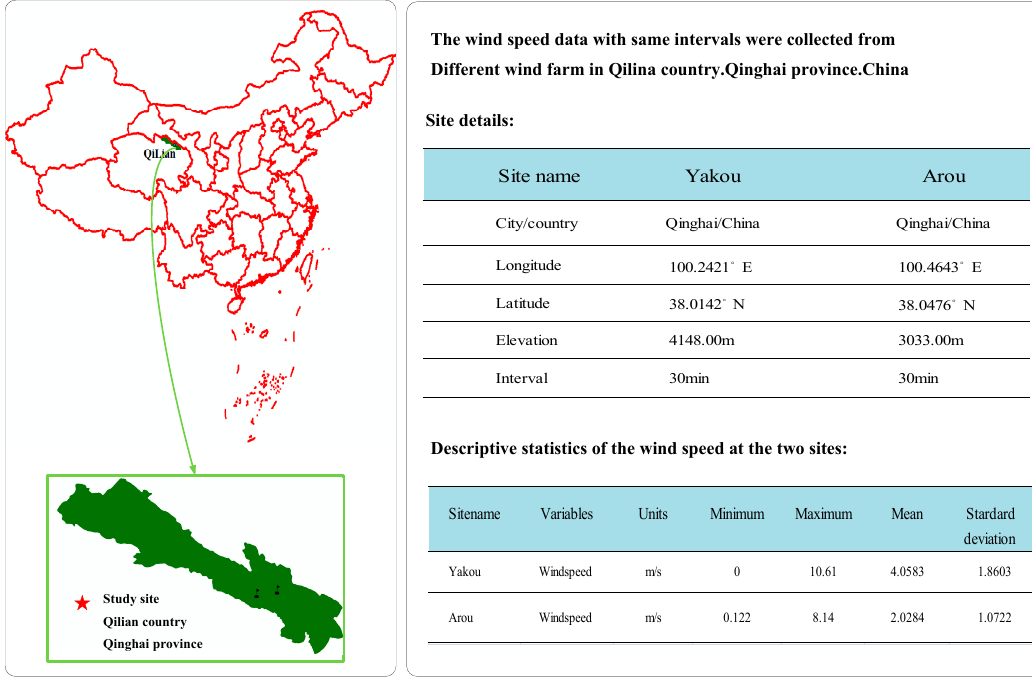
Figure 3. Descriptive information about wind-speed data of sites in the Qilian region.